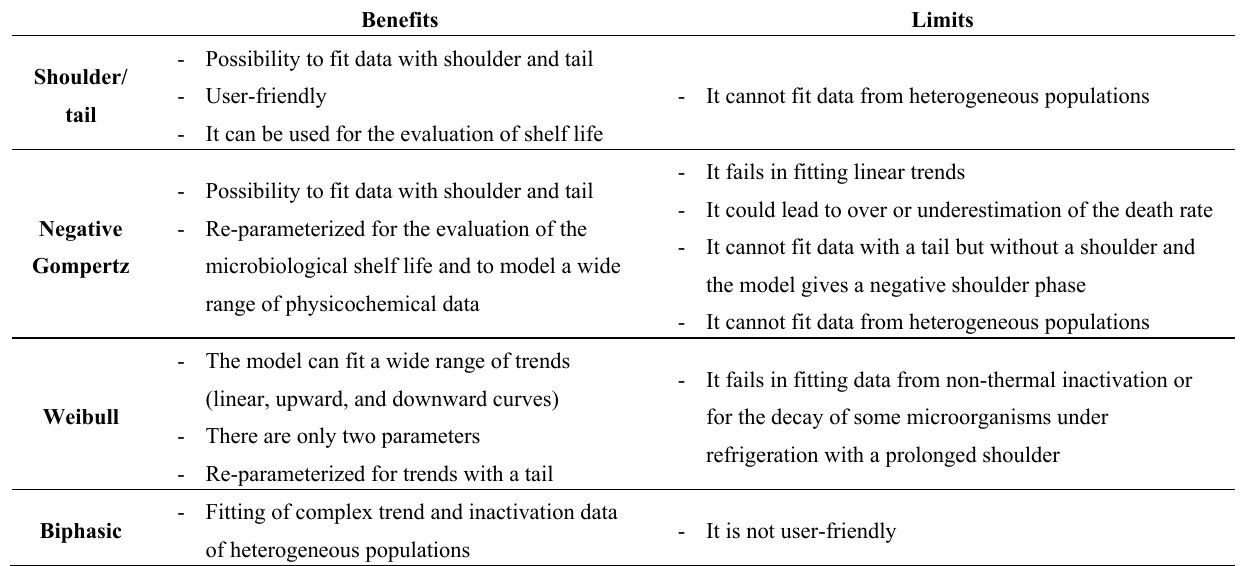
Table 1. Overview of the benefits and the limitations of the most used